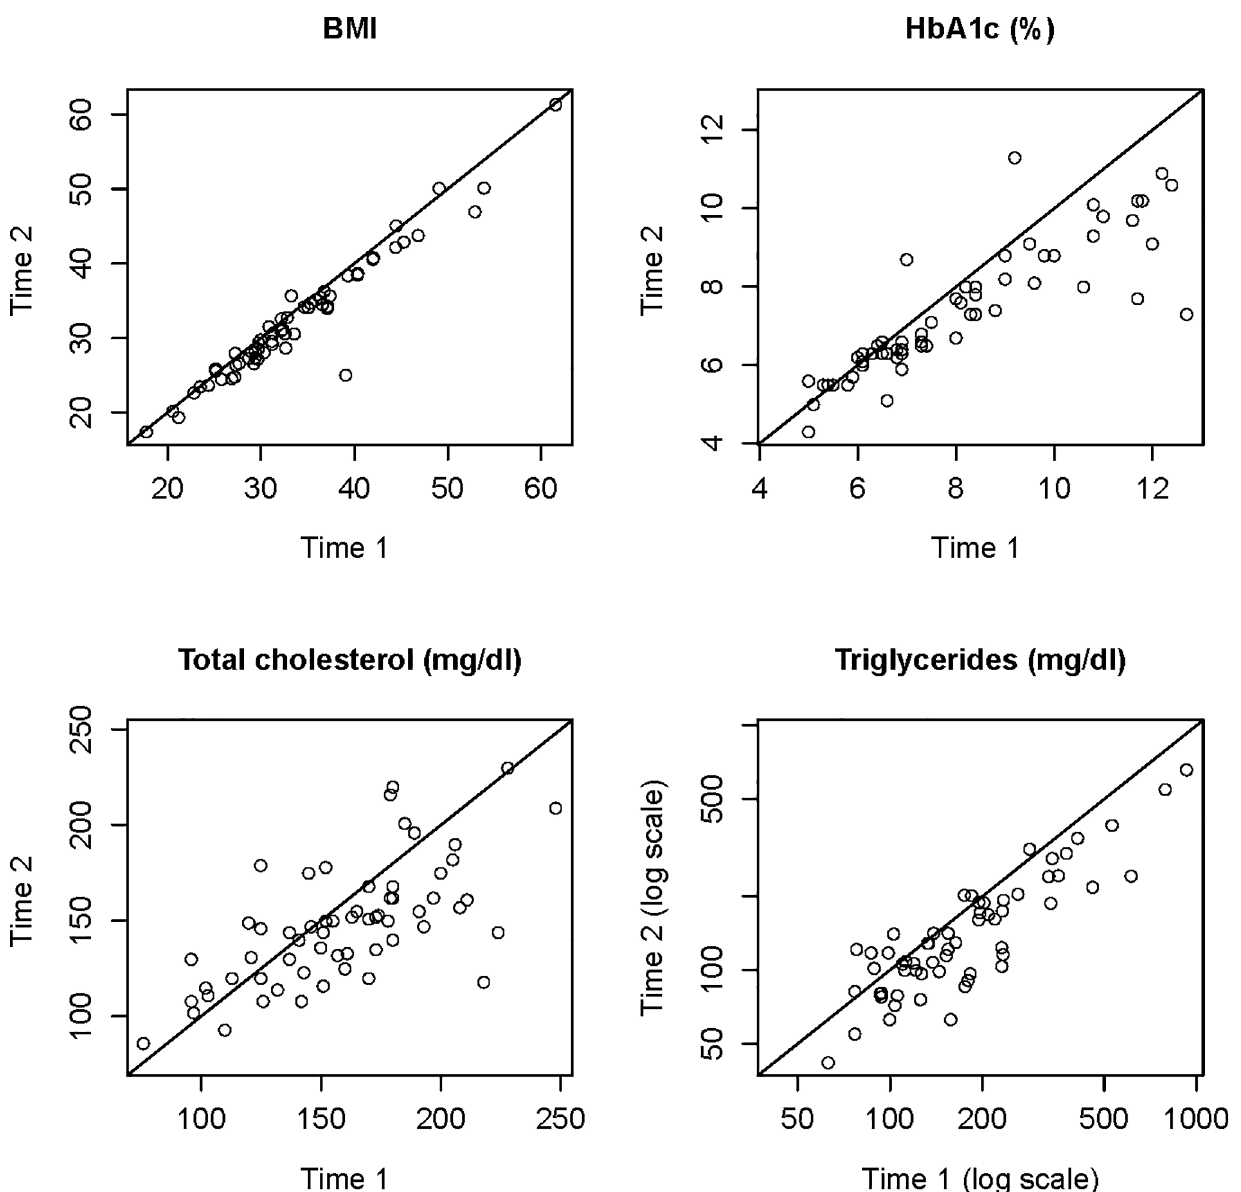
Fig 2. Agreement plots (n = 60). For each clinical parameter, the patient ’ s value at baseline screening (time 1) is on the horizontal axis and the 6-month follow-up value (time 2) is on the vertical axis. The plotted line is the line of perfect agreement between times 1 and 2. Points below the line represent a decrease from time 1 to time 2, while points above the line represent an increase from time 1 to time